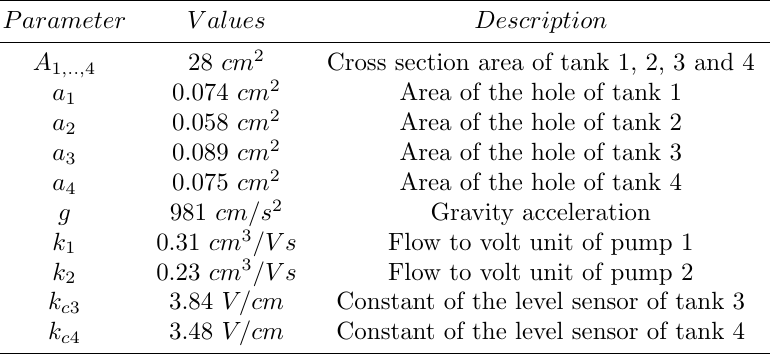
Table 2: Parameters values and description for quadruple tank